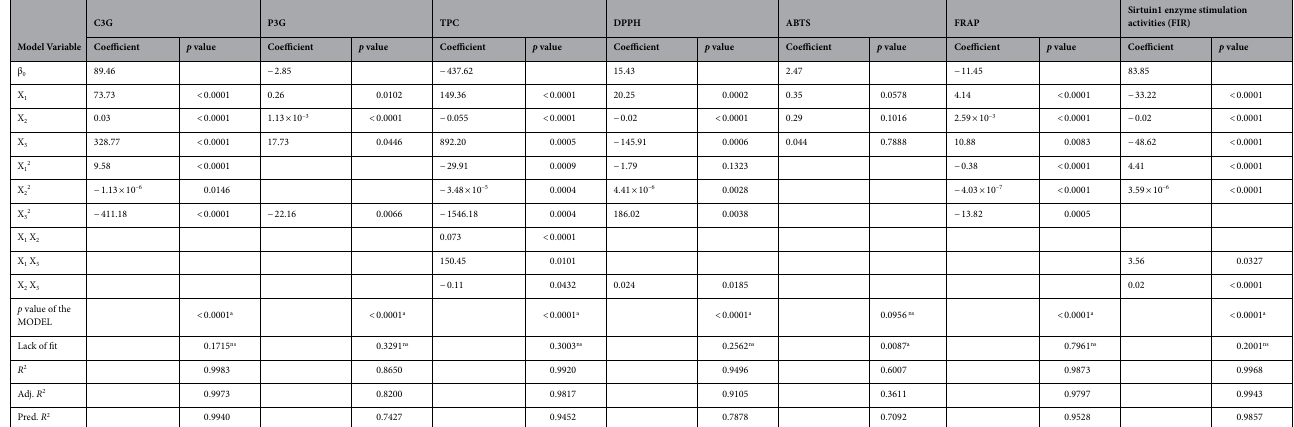
Table 3. The regression equations based on ANOVA analysis of PEF-AWE process of BRG. β 0 = Intercept, X